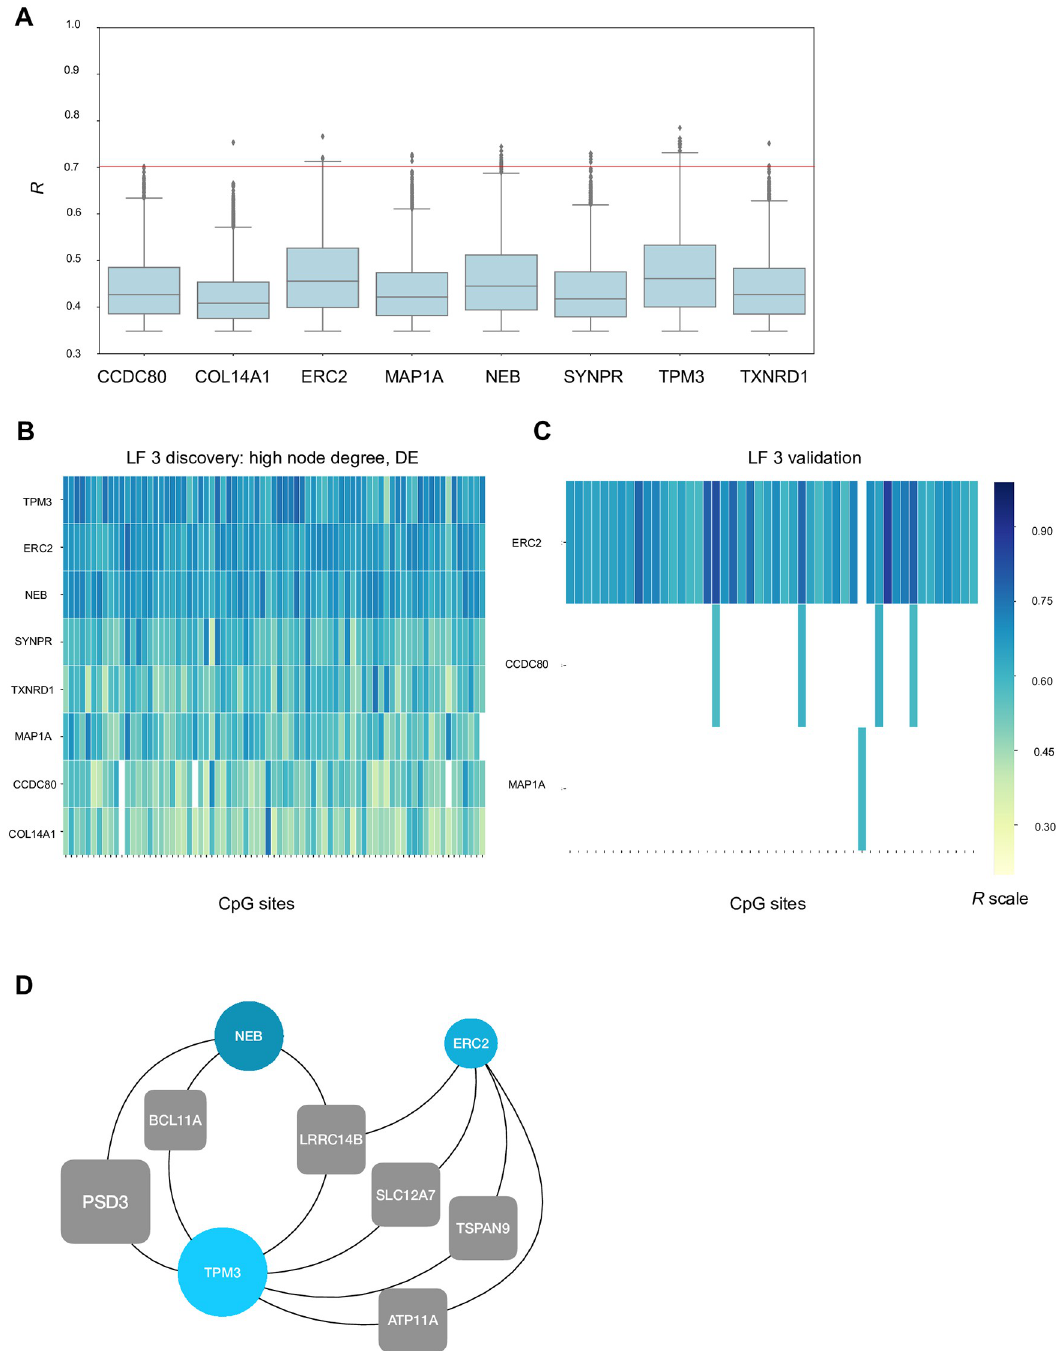
Fig 7. Top gene features for latent factor 3 with differential gene expression between DCM and controls. A) The boxplots depict the correlations for the genes that have a high node degree and are also significantly differentially expressed between DCM and controls. B ) The contingency matrix depicts the correlations for high node degree and significant DCM association features in the discovery and validation cohorts. All CpG sites are not listed in the contingency matrix, refer to S10 Fig for the full list. C) For the TPM3 , NEB and ERC2 genes, we plot a network for the CpG sites shared between them. The blue nodes represent the genes and the grey boxes represent the CpG sites. The CpG sites are named by the genes that they are part of.